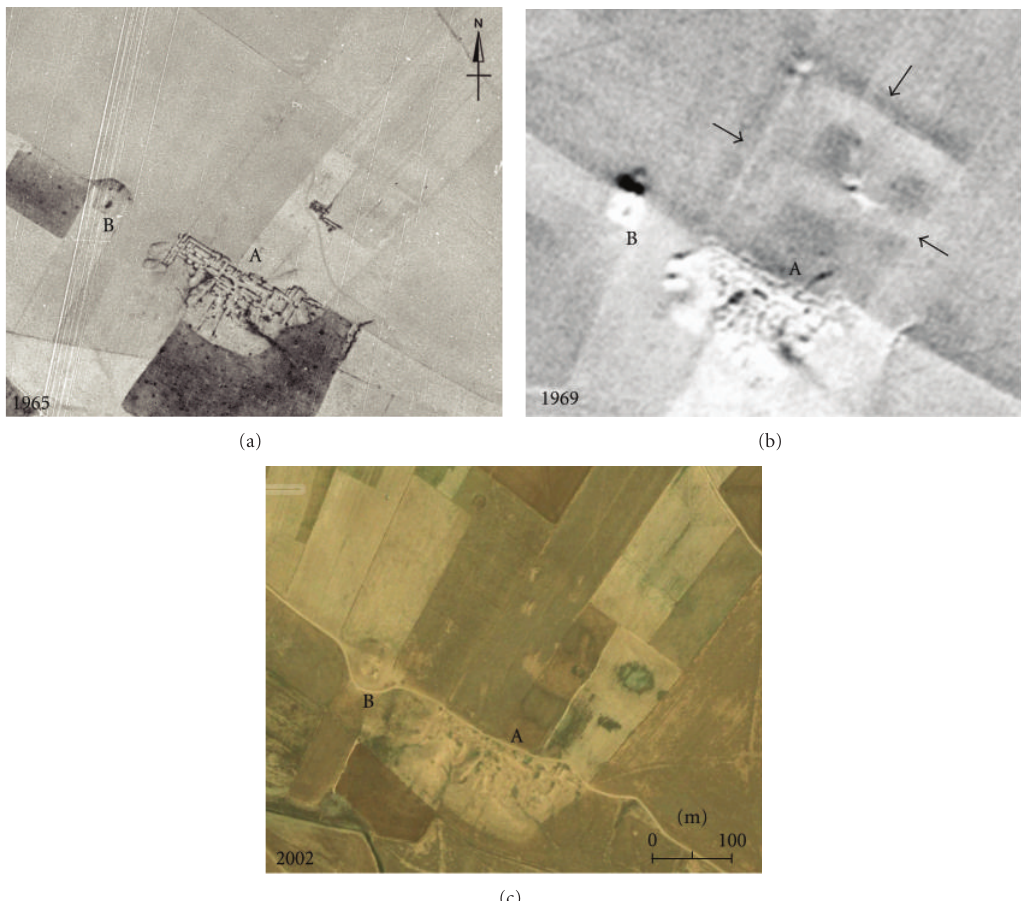
Figure 12: Dur-Sharrukin: the area of Palace F (A) and Gate 5 (B) in a Gambit KH-7 photo (1965), in a Corona KH-4B photo (1969), and in a pan-sharpened (bands 3-2-1) QuickBird-2 image